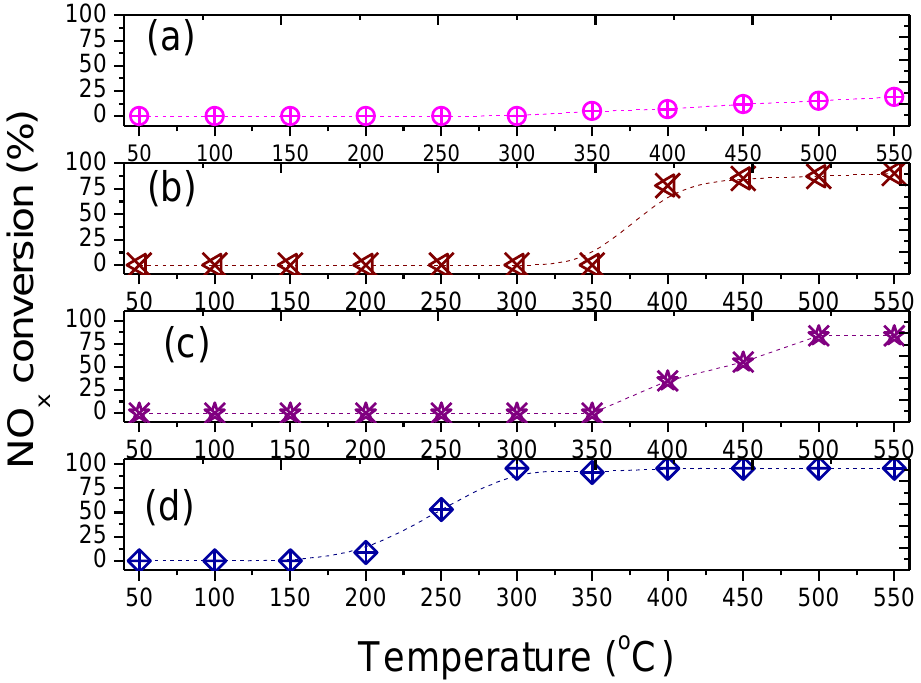
Figure 7. Influence of the temperature on overall NO x conversions using the MeMo / Nb 2 O 5 catalysts: ( a ) Nb 2 O 5, ( b ) CoMo / Nb 2 O 5 , ( c ) NiMo / Nb 2 O 5 , and ( d ) PtMo / Nb 2 O 5. Reaction conditions: 500 ppm of NO, 1000 ppm of CO, and balance with He. Catalyst mass = 150 mg, total flow rate = 80 mL · h − 1 and GHSV = 48,000 h − 1 .